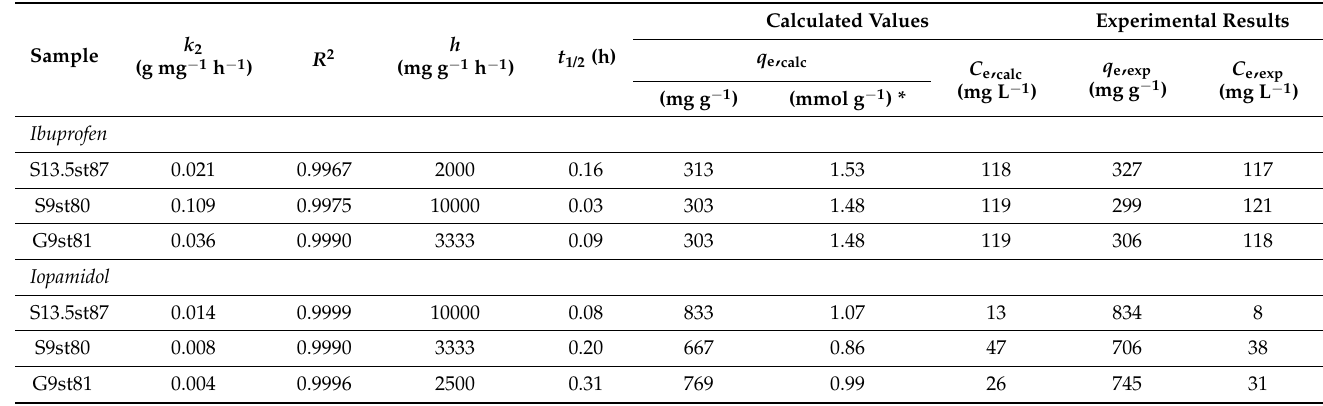
Table 4. Pseudo-second order model parameters of the kinetic adsorption of ibuprofen and iopamidol onto the carbons obtained by steam activation of the sisal and glucose-derived acid-chars.